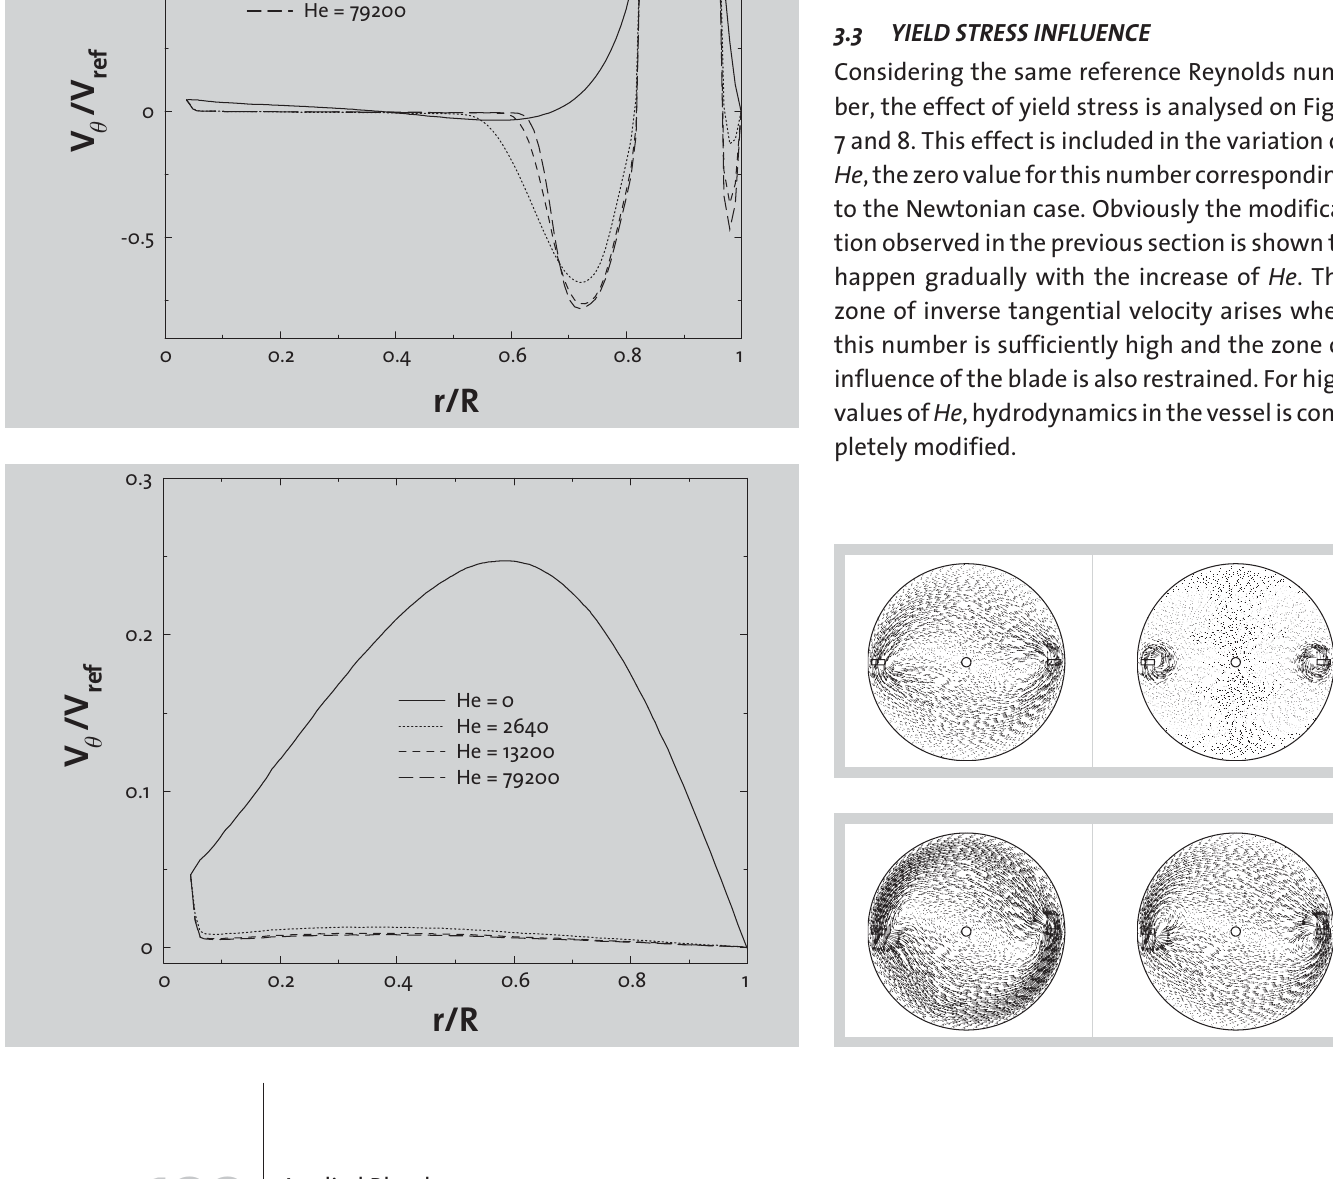
Figure 6 (left above): Tangential velocity on the median plane (Re=13.8). Figure 7 (left middle): Tangential velocities on the impeller plane for different yield stresses. Figure 8 (left below): Tangential velocities on the median plane for different yield stresses. Figure 9 (right above): Velocity field for Newtonian fluid (left) and viscoplastic fluid (right) - Re=13.8. Figure 10 (right below): Velocity field for Newtonian fluid (left) and viscoplastic fluid (right) -